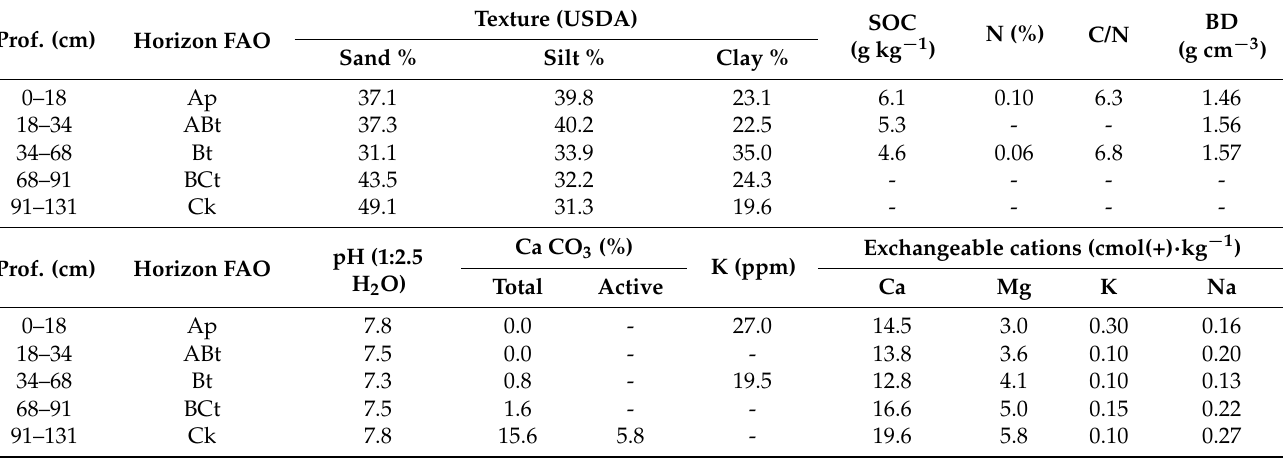
Table 1. Analytical data from the trial soil pit in 1985. (SOC = soil organic carbon; BD = bulk density). Prof.